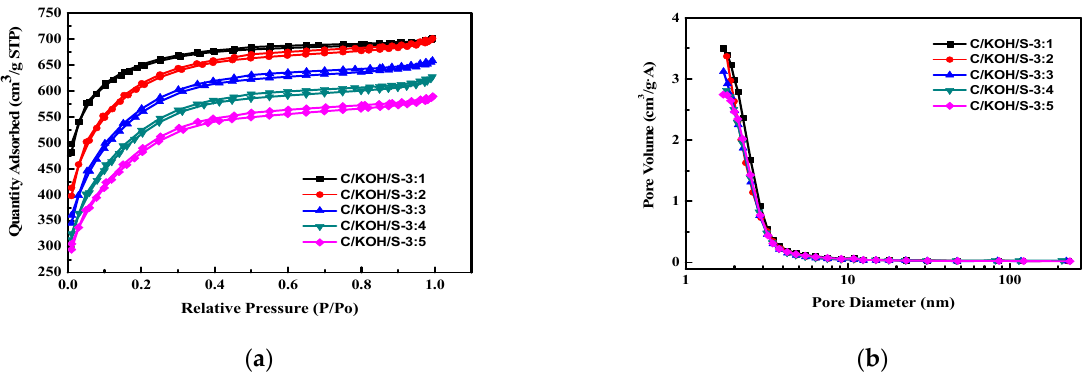
Figure 3. Nitrogen adsorption and desorption curve of heteroatom-co-doped activated carbon ( a ) and pore size distribution curve of heteroatom-co-doped AC (C/KOH/S sample) ( b ).